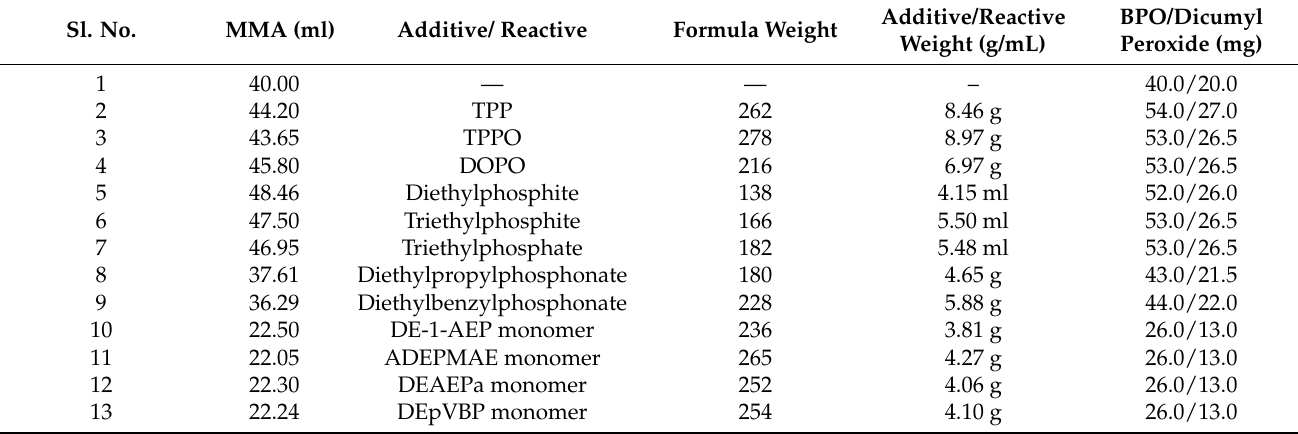
Table 2. Details of the preparative data for the bulk